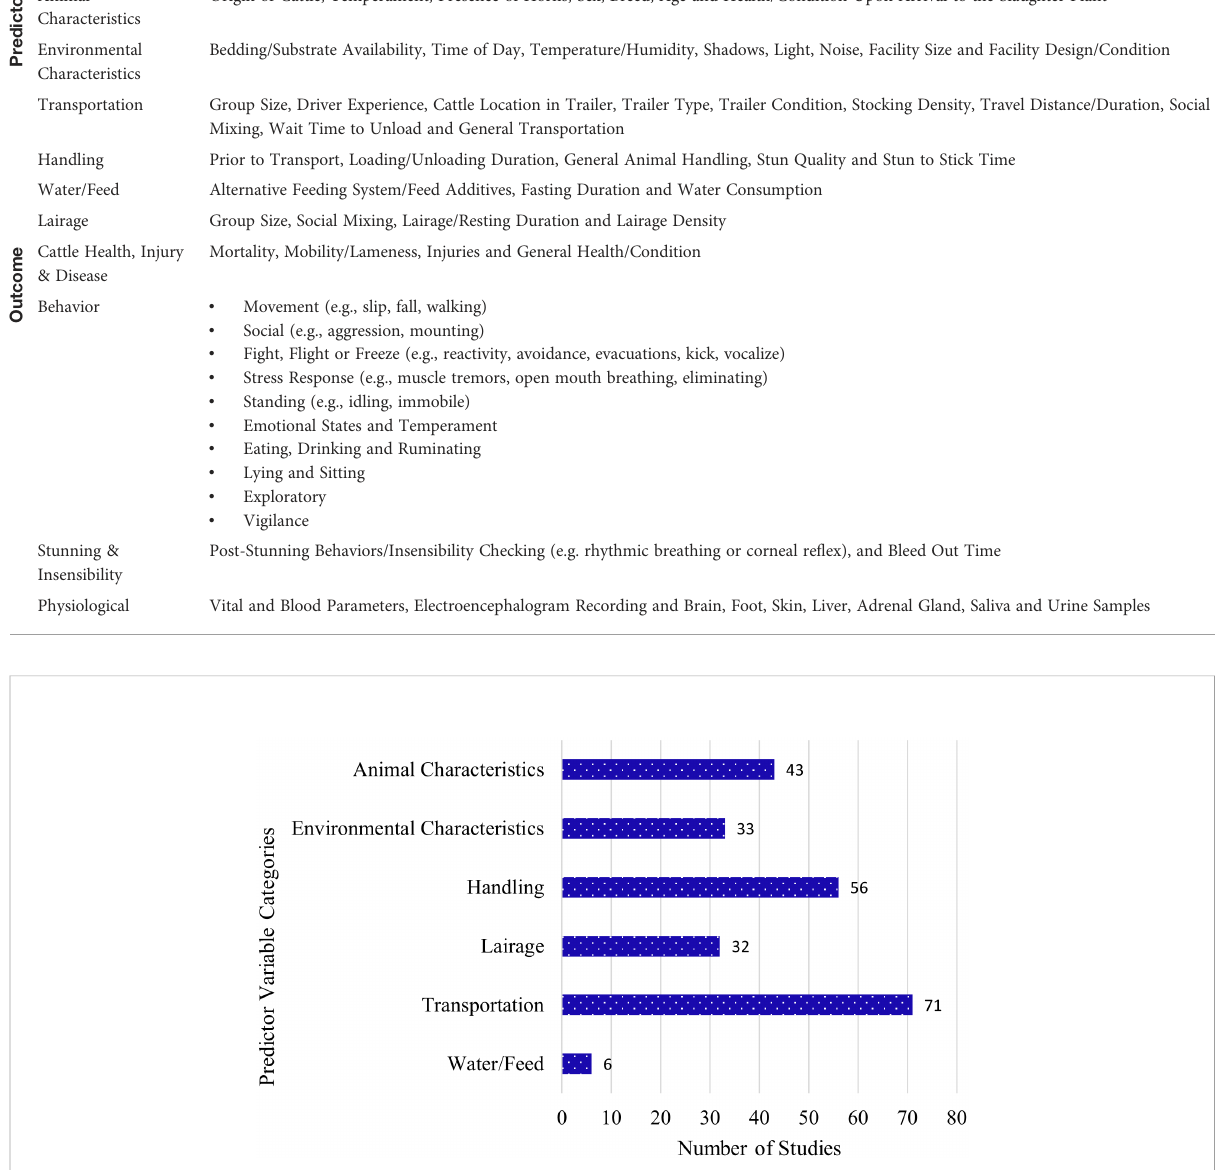
TABLE 2 Preslaughter management factors and fed beef cattle welfare indicator categories with subsequent measurable variables of interest from studies included in analysis (n = 69) for a scoping review. Category Measurable Variables Origin of Cattle, Temperament, Presence of Horns, Sex, Breed, Age and Health/Condition Upon Arrival to the Slaughter Plant o r Animal Characteristics c t d i e Environmental P r Characteristics